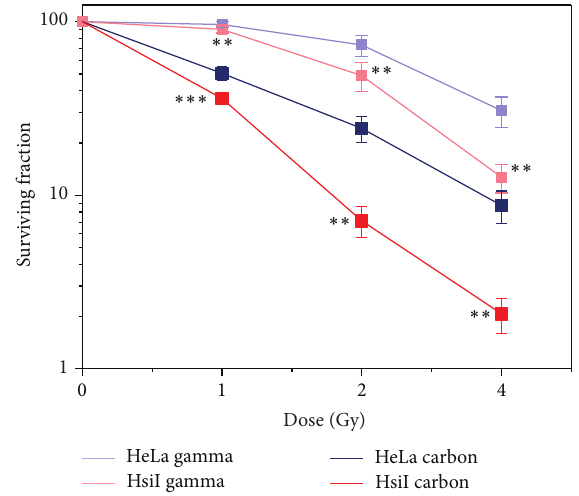
Figure 3: Surviving Fraction of HeLa and HsiI after irradiation with carbon ion beam and gamma radiation. Each point represents the mean with standard deviation. The significance level of difference of % survival at the same dose of both carbon ion beam and gamma radiation for each cell type was denoted by 𝑃 values. “ ∗∗ ” means ( 0.001 < 𝑃 ≤ 0.01 ) and “ ∗ ∗ ∗ ” means ( 𝑃 ≤ 0.001